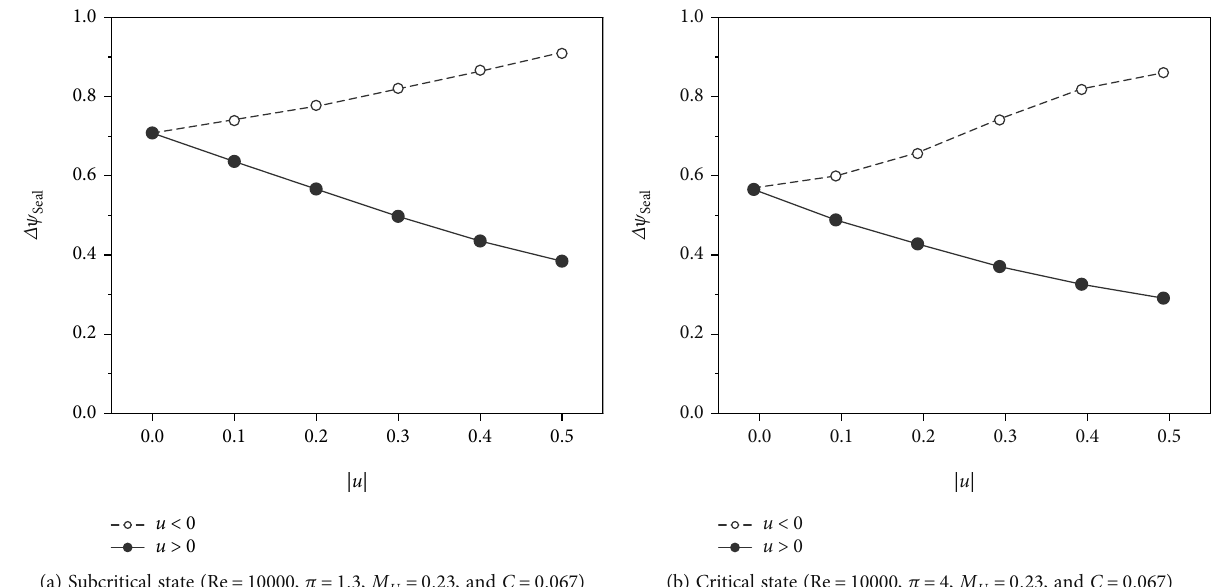
Figure 17: Labyrinth seal pressure